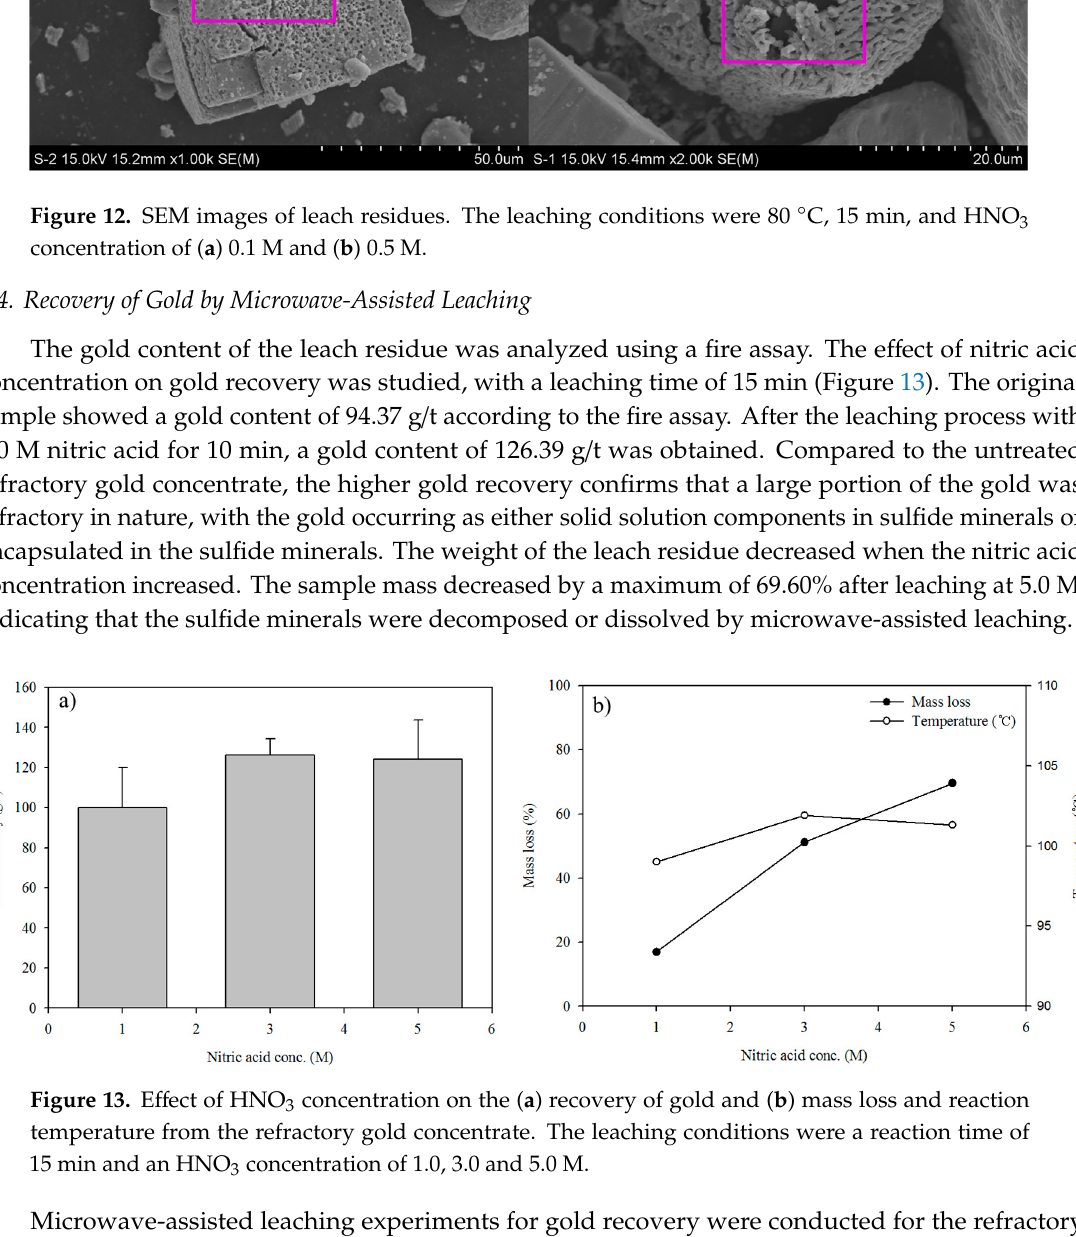
Figure 12. SEM images of leach residues. The leaching conditions were 80 °C, 15 min, and HNO 3 concentration of (a) 0.1 M and (b) 0.5 M.